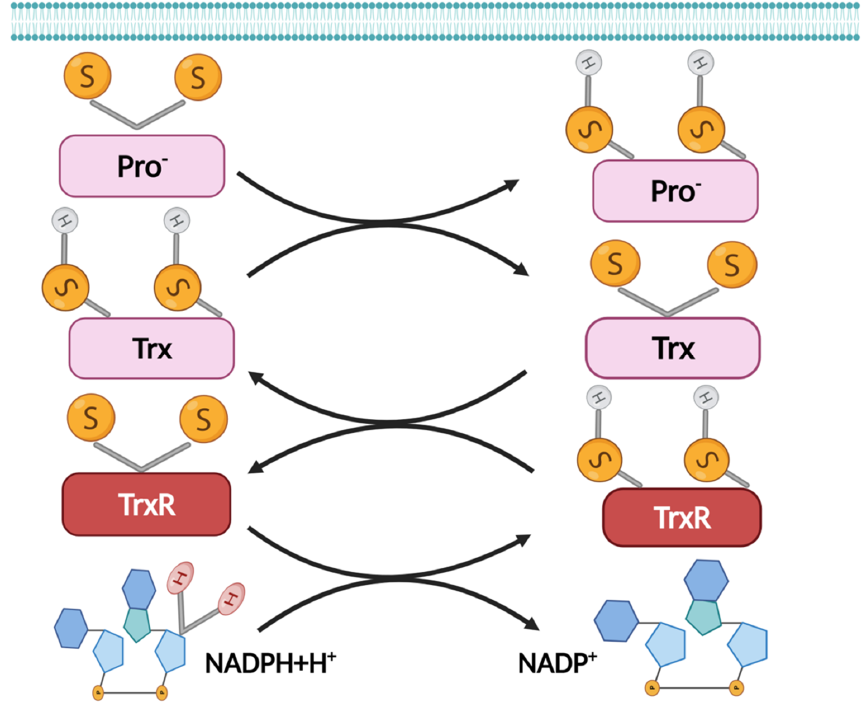
Figure 3. Thioredoxin system. Trx in the oxidized form, Trx-S2, or the reduced form, Trx-(SH)2. In the reduced state, Trx directly reduces disulfides in oxidized substrate proteins (Pro − -S2). The oxidation reaction is reversible and is maintained by thioredoxin reductase TrxR, which is sustained by the electron donor NADPH. Created with BioRender.com, accessed on 19 June 2022.